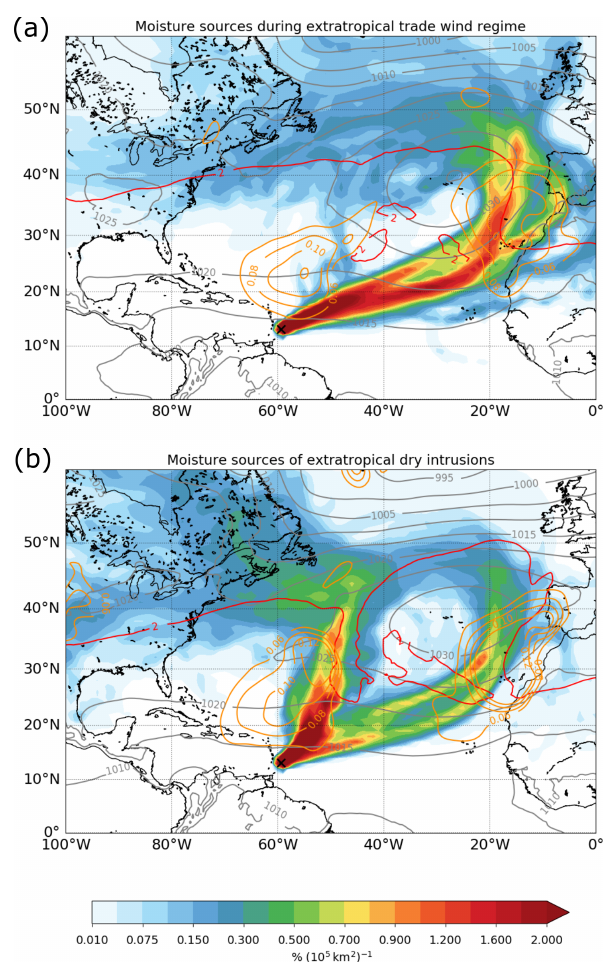
Figure 6. Moisture sources during the time period from 25 January to 18 February 2018, separately for (a) the extratropical trade wind regime (62% occurrence frequency in 2018) and (b) the extratropi- cal dry intrusion regime (32% occurrence frequency in 2018). The percental contribution of uptakes per 10 5 km 2 to the final specific humidity in the boundary layer at the BCO is shown in colours. The composite 2pvu isoline on the 330K isentrope is shown by the red contour line. Regions of subsidence averaged during the regimes are shown by orange contours of vertical wind ω at 500hPa (in Pas − 1 ). The grey contour lines show the regime averages of sea level pres- sure in hectopascals. The composite fields of sea level pressure, PV at 330K and ω are shown for 4d prior to the arrival of the air parcels in